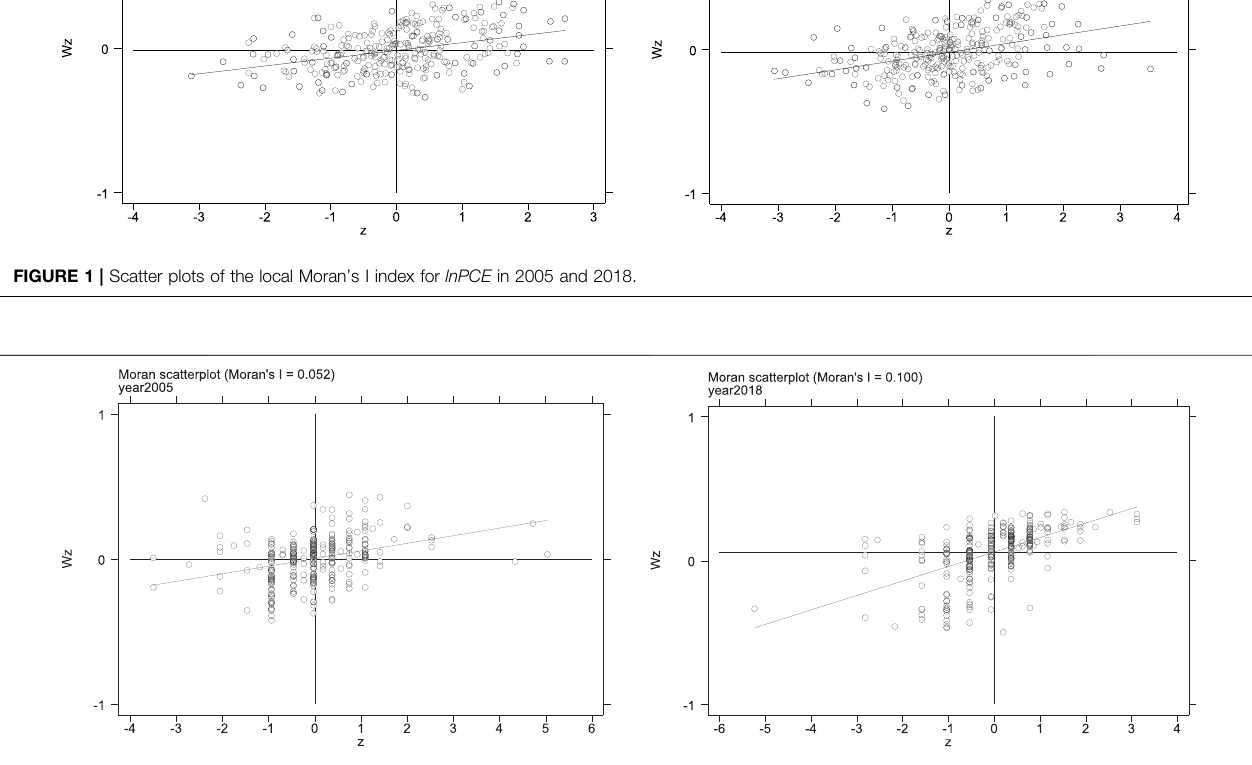
FIGURE 2 | Scatter plots of the local Moran ’ s I index for lnEGT in 2005 and 2018.